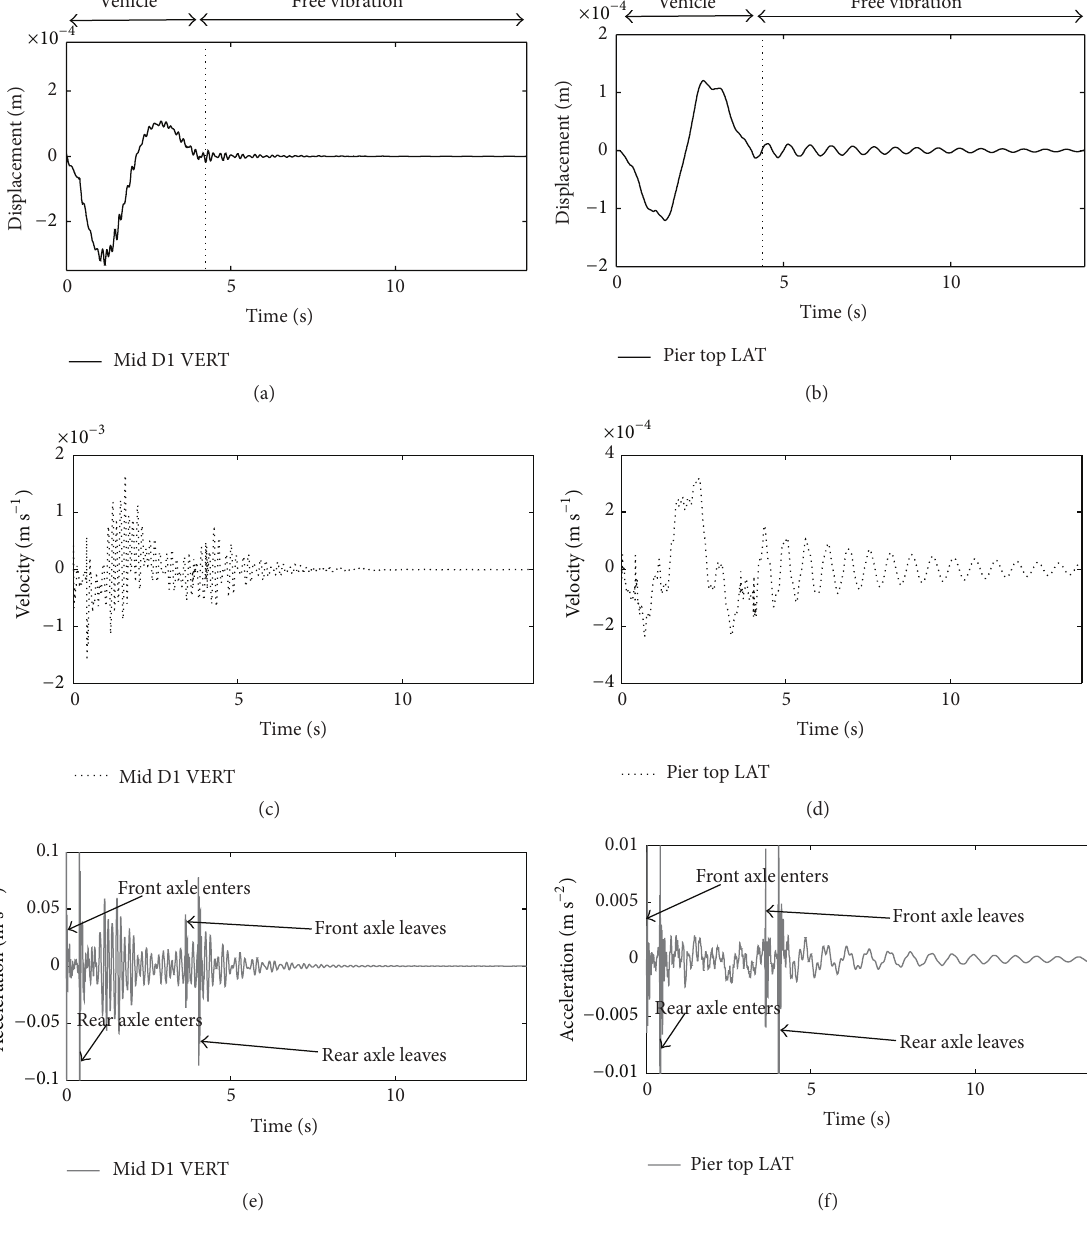
Figure 8: Example signals from model for vehicle traversing at 50 kmhr −1 with 10seconds of free vibration and a Class “ 𝐴 ” road profile. (a) Vertical displacement response at mid-span of span 1; (b) horizontal displacement at top of pier; (c) vertical velocity response at mid-span of span 1; (d) horizontal velocity at top of pier; (e) vertical acceleration response at mid-span of span 1; (f) horizontal acceleration at top of pier. All signals are damped at